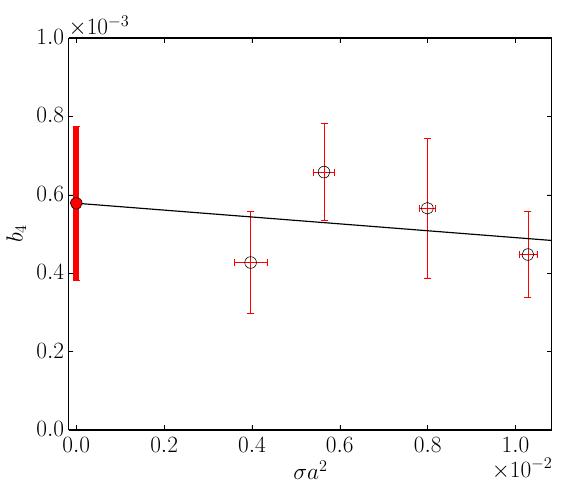
Figure 12 . Results obtained for b 4 in SU(2) Yang-Mills theory, together with their continuum extrapolation (reported as filled